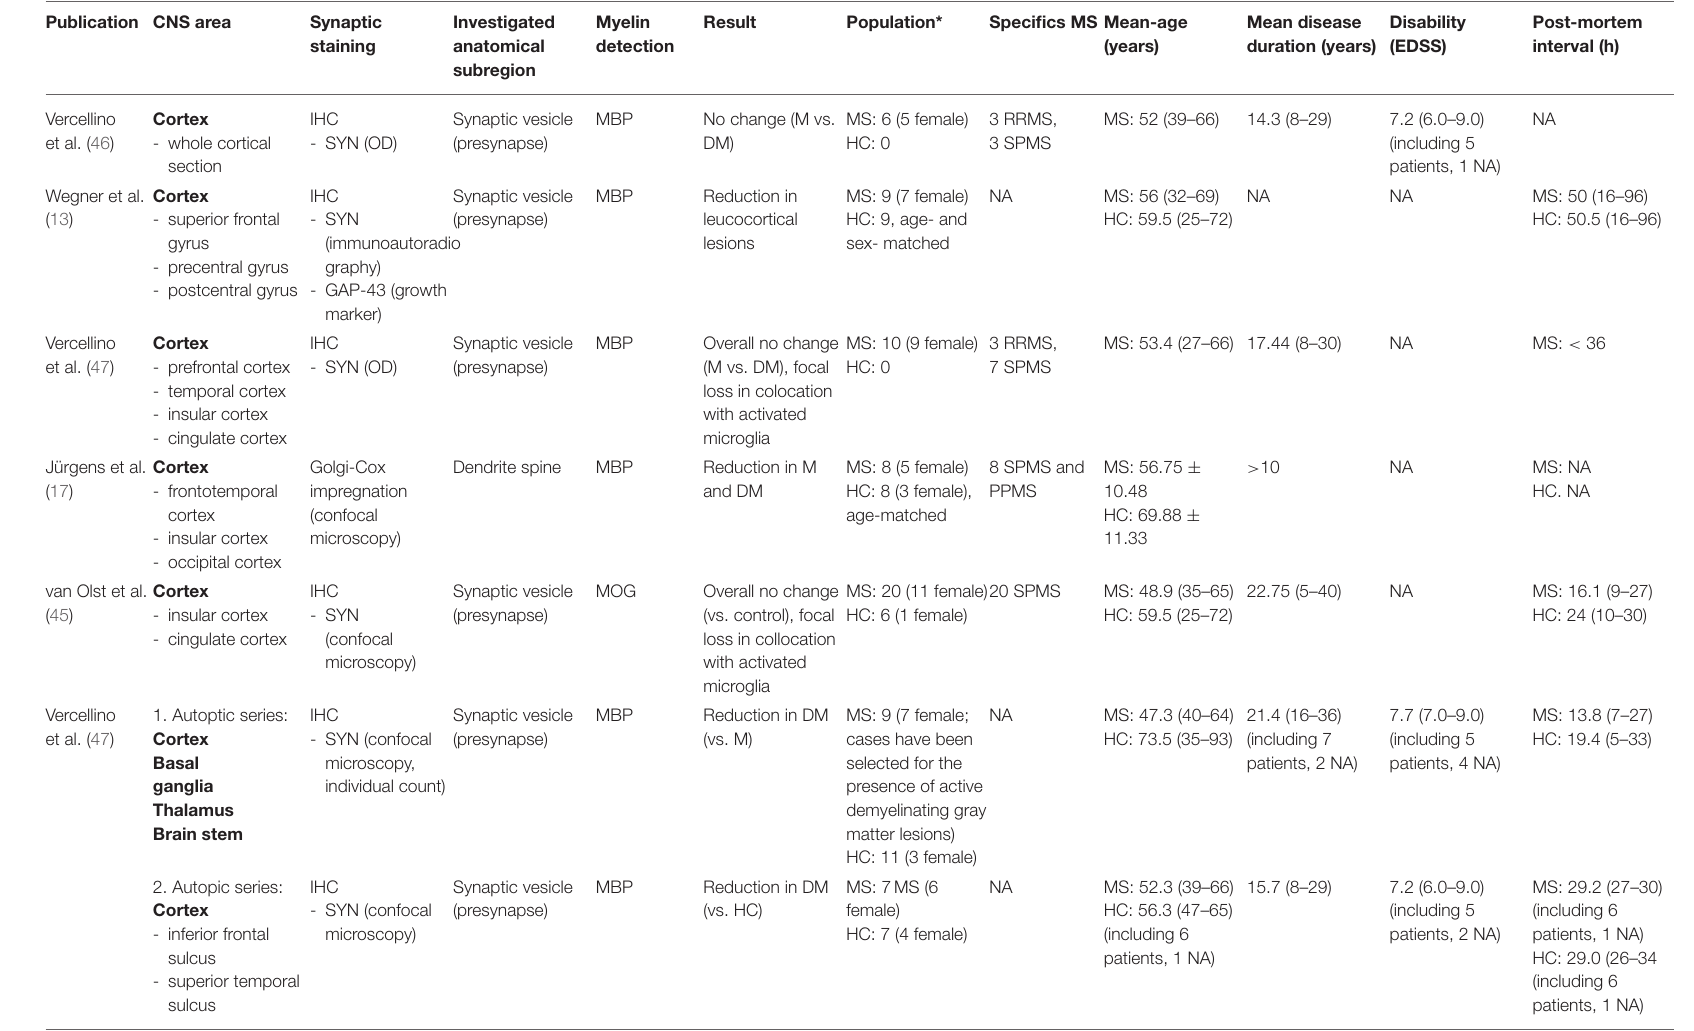
TABLE 1 | An overview of publications that investigated the synaptic density in the cortex along with extracted